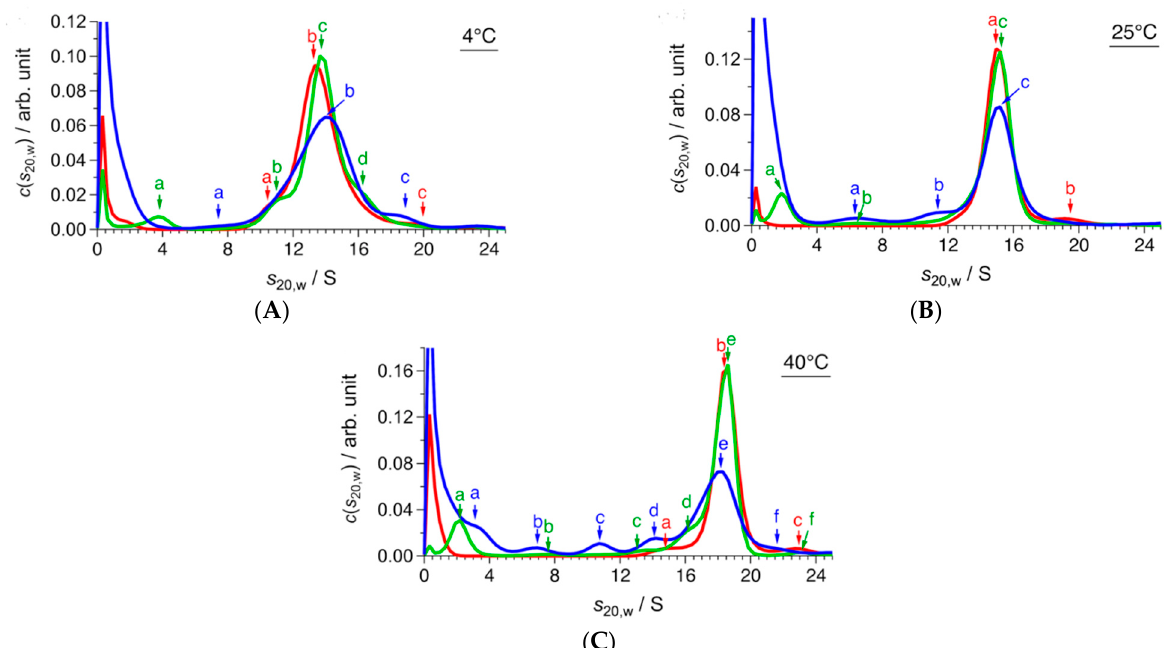
Figure 1. SV-AUC results of CgHspB1 WT at ( A ) 4 °C, ( B ) 25 °C, and ( C ) 40 °C. Red, green, and blue lines represent c ( s 20,w ) at 1.5 mg/mL, 0.5 mg/mL, and 0.1 mg/mL, respectively. Colored arrows and letters (a, b, c, d, e, f) corresponding to the data with the same colors show the peak positions whose parameters are listed in Table 1.